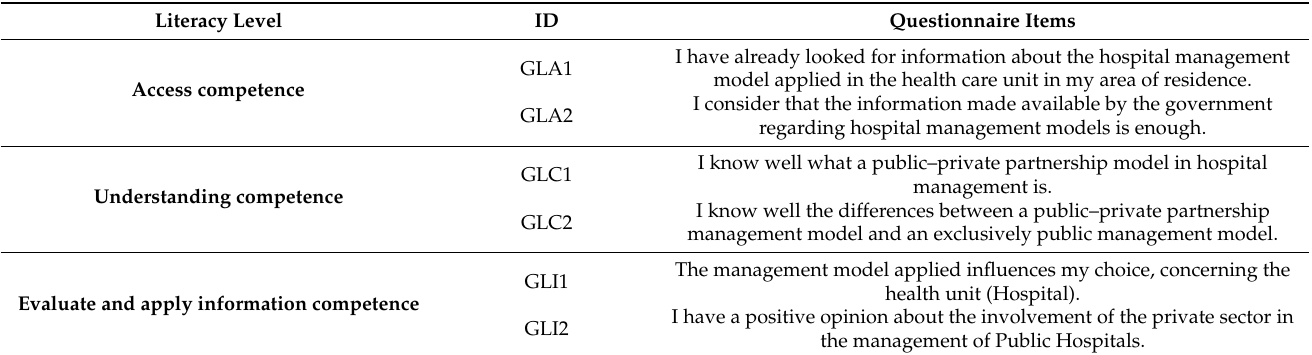
Table 4. Items of the variable literacy level.